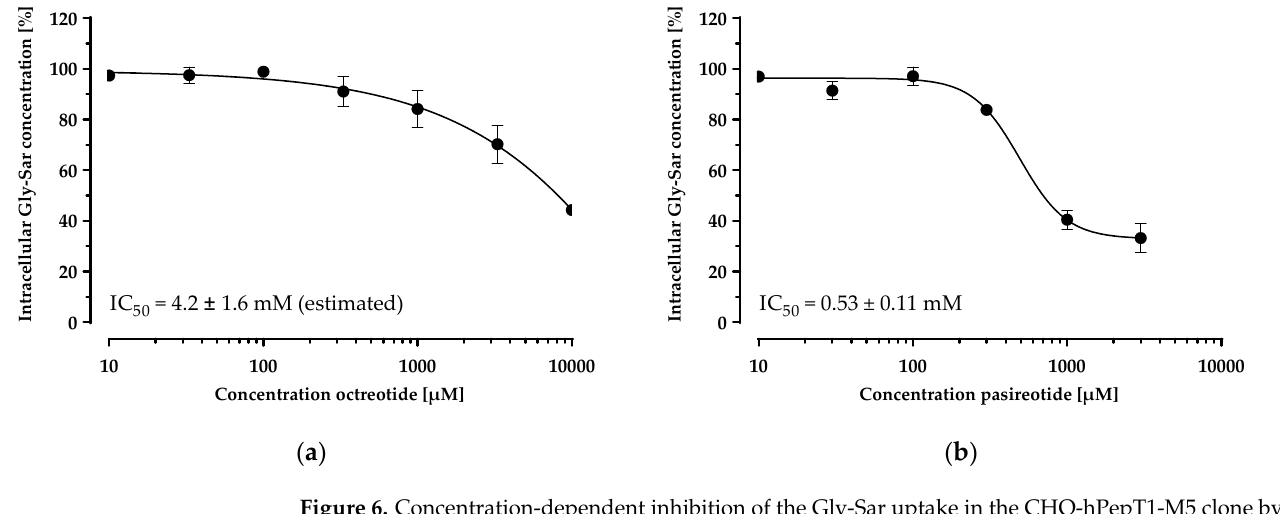
Figure 6. Concentration-dependent inhibition of the Gly-Sar uptake in the CHO-hPepT1-M5 clone by octreotide ( a ) and pasireotide ( b ). The data points represent the mean ± S.E.M. of three independent experiments with each concentration tested in octuplets.